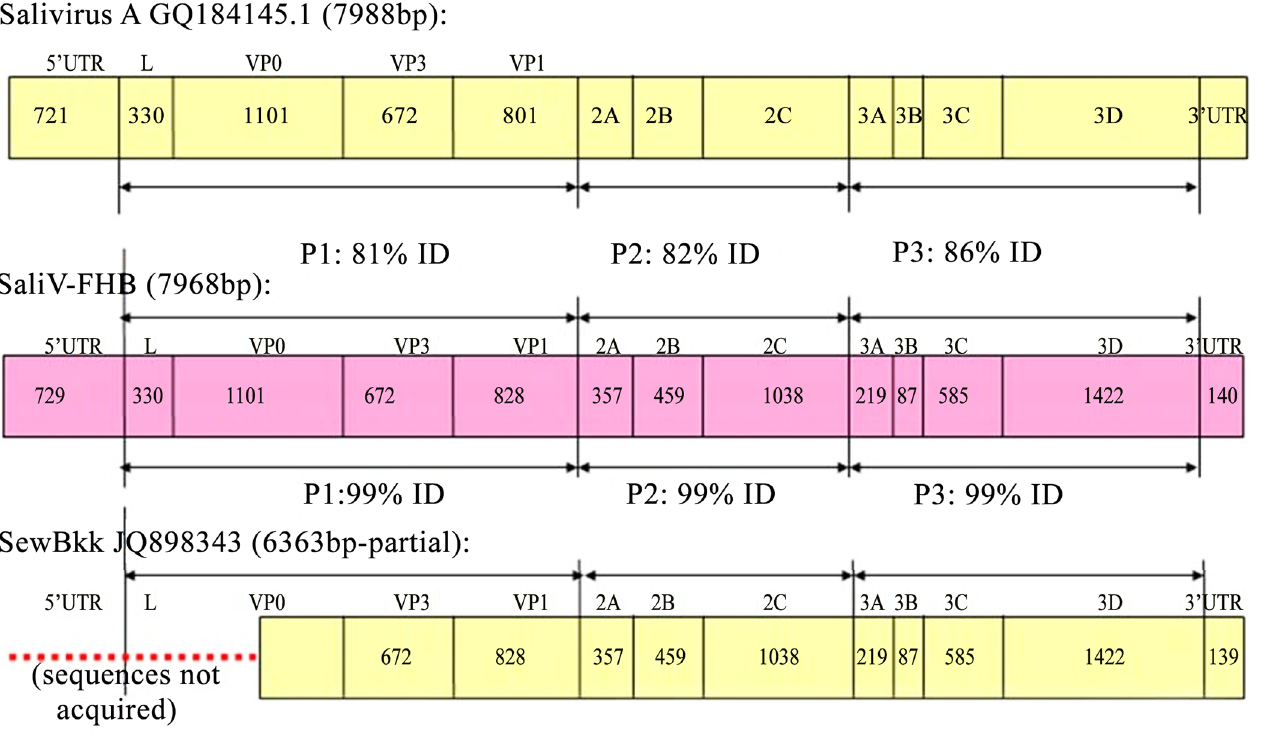
Fig 3. Compare of full genome sequences between SaliV-FHB and salivirus A and SaliV-SewBKK. P1 region of SaliV-FHB shared lowest nt identity to that of Salivirus A, while P1, P2 and P3 regions of SaliV-FHB shared 99% nt identities to those of SaliV-SewBKK. "ID" stands for identity.